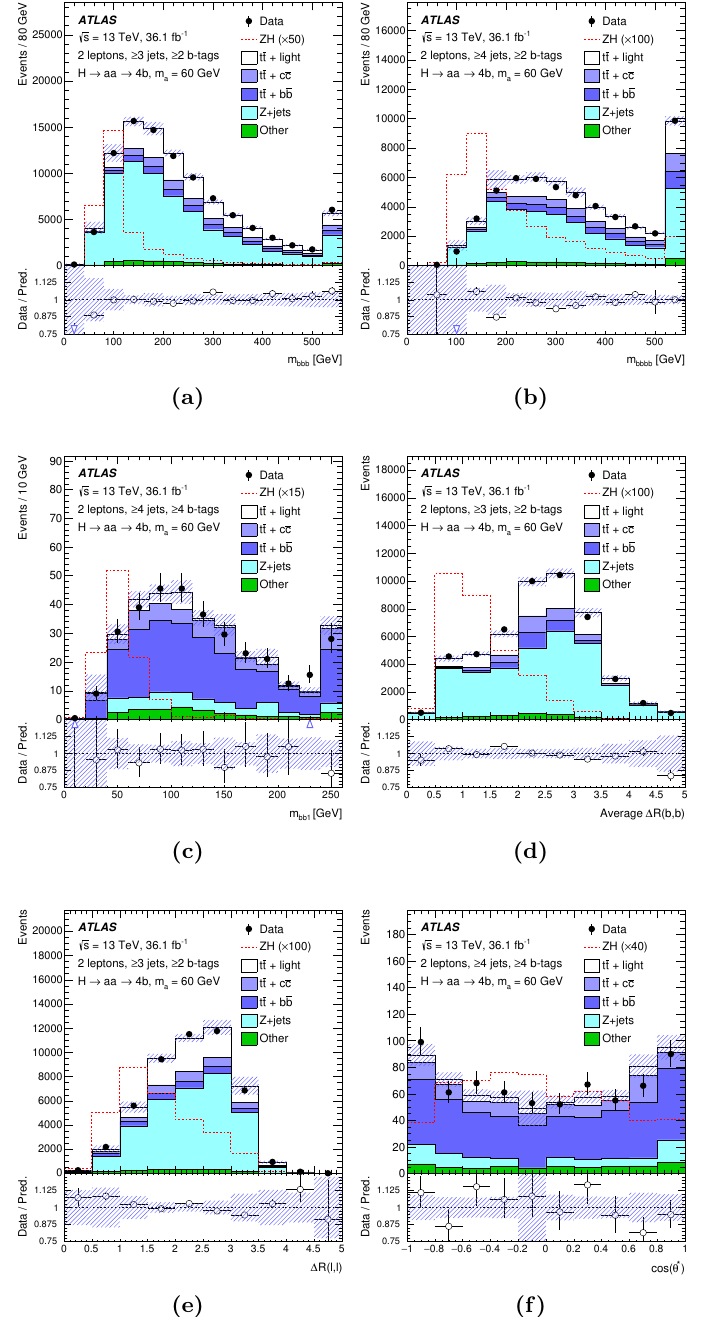
Figure 5. Comparison of data with the post-(cid:12)t background estimates for (a) m bbb , (b) m bbbb , (c) m bb 1 , (d) average (cid:1) R ( b , b ), (e) (cid:1) R ( ‘ , ‘ ) and (f) cos (cid:18) (cid:3) in the dilepton sample inclusive in number of jets and b -tagged jets. Comparisons use events with 3 jets, except when 4 jets are necessary (cid:21) (cid:21) to de(cid:12)ne the variable, in which case events with 4 jets are used. Distributions for the signal (cid:21) model ( ZH , H 4 b ), with m a = 60 GeV, normalized to the SM pp aa ZH cross-section, ! ! ! assuming ( H 4 b ) = 1 and scaled by a factor as indicated in the (cid:12)gure, are overlaid. The aa B ! ! hashed area represents the total uncertainty in the background. The last bin contains the